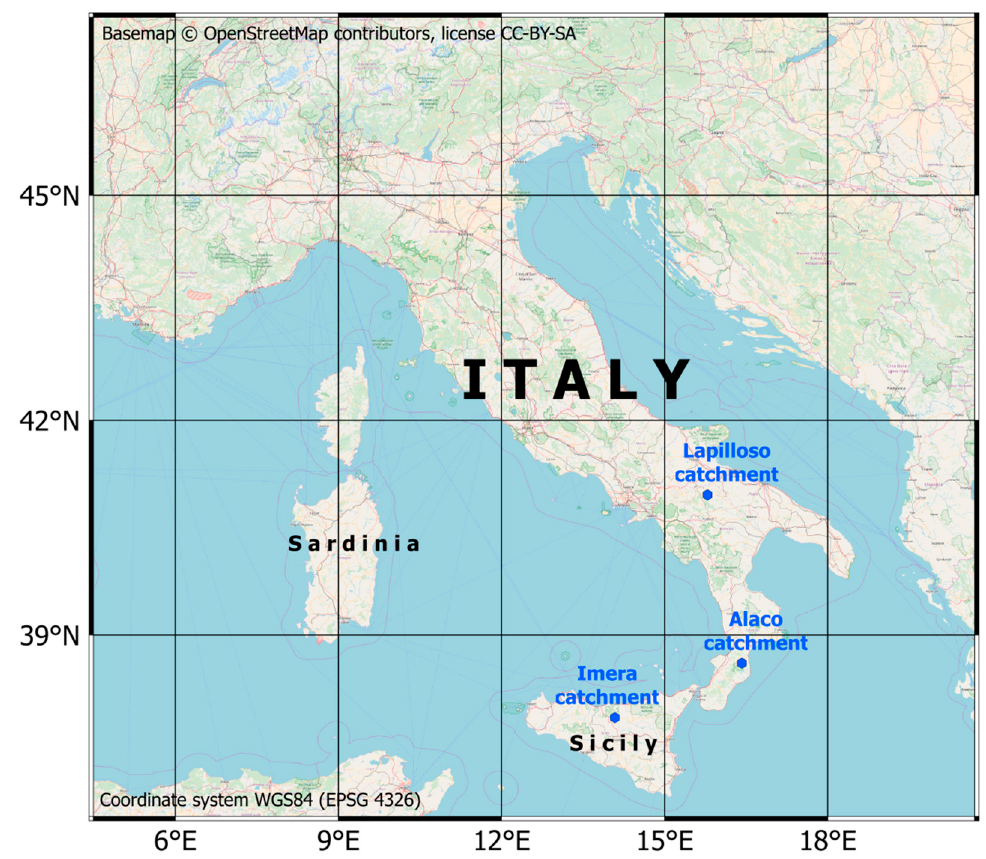
Figure 5. Geographical setting of test catchments.